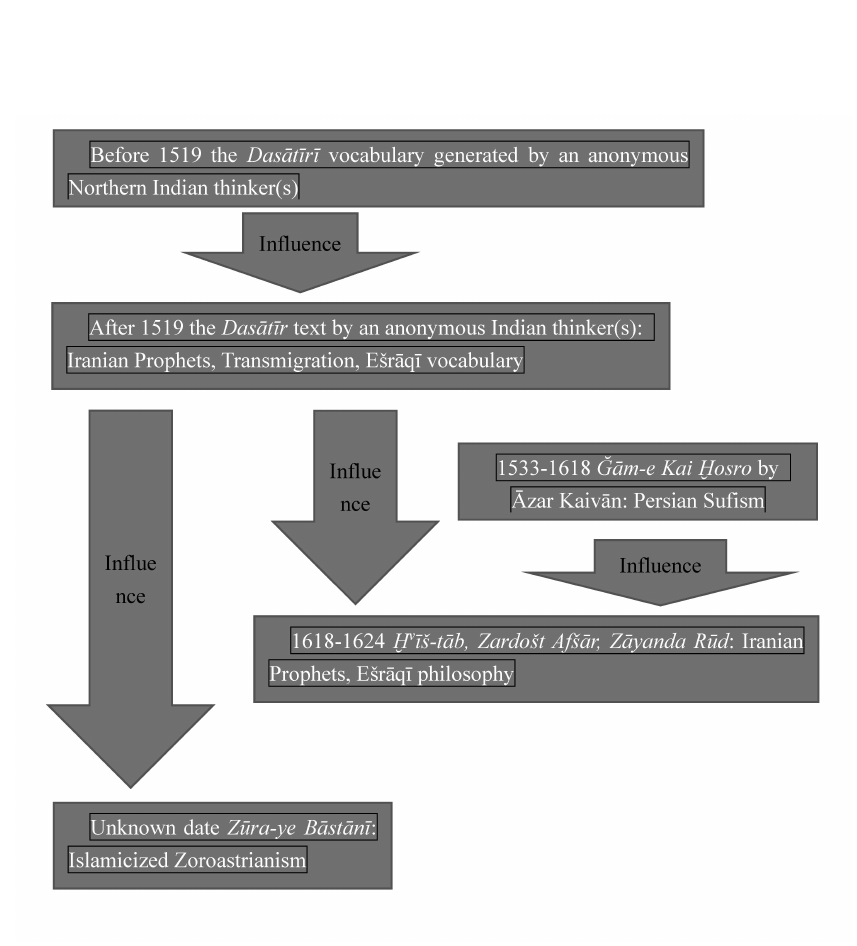
Figure 3 Diagram depicting the paths of influence among the six extant texts of the Āẕar Kaivān